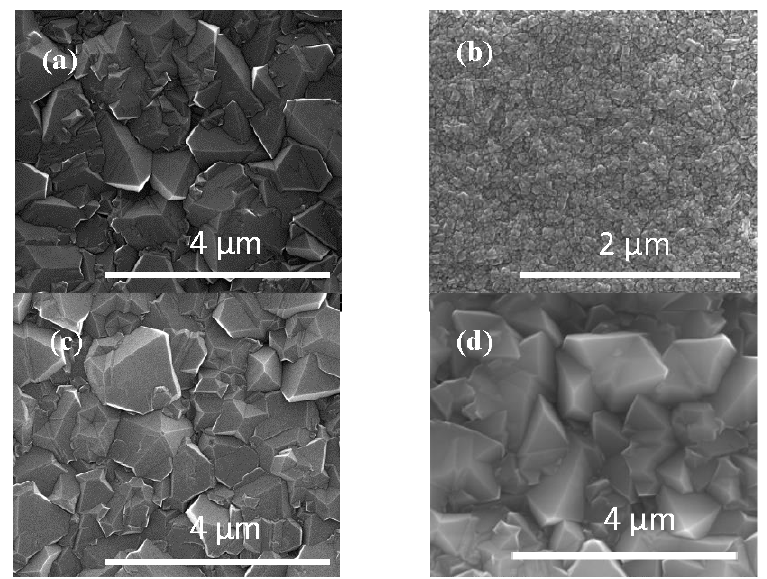
Figure 3. Scanning Electron Microscopy (SEM) of ( a ) Microcrystalline Diamond (MCD); ( b ) Nanostructured Diamond (NSD) ( c ) Boron–Nitrogen Diamond (BND), and ( d ) Boron-Doped Diamond (BDD).